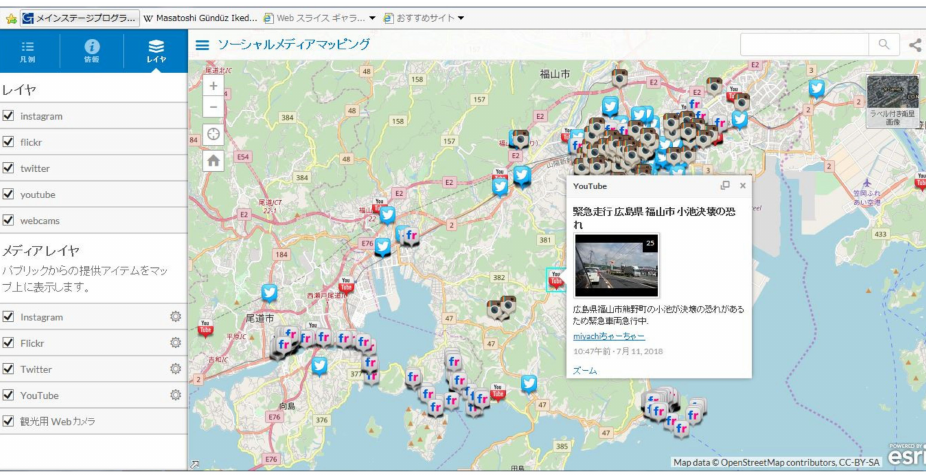
Figure 7. Submissions on YouTube concerning Mabi-cho, Kurashiki City, Okayama Prefecture.